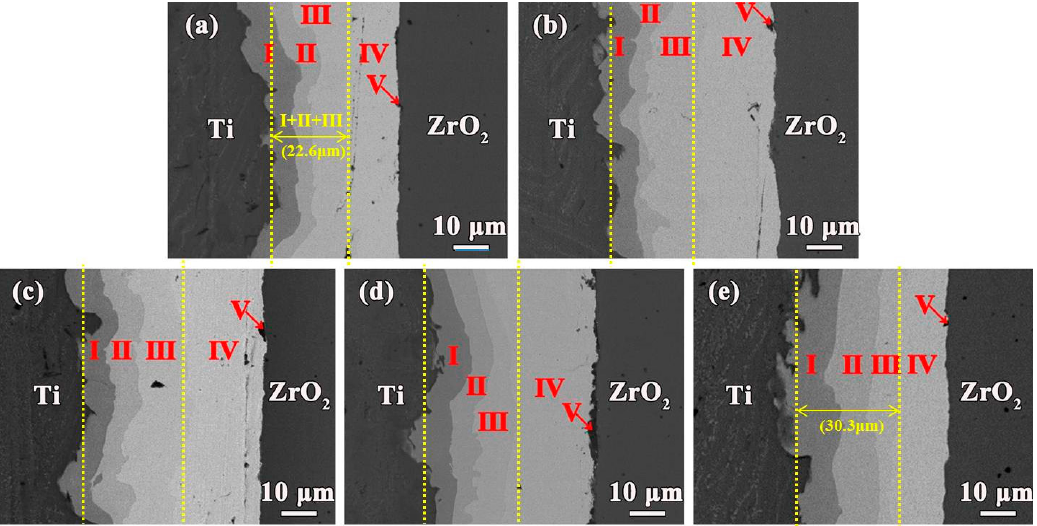
Figure 6. Microstructure of the titanium/Au/ZrO 2 joint brazed at 1150 °C for different holding times: ( a ) 5 min, ( b ) 10 min, ( c ) 15 min, ( d ) 20 min and ( e ) 30 min .